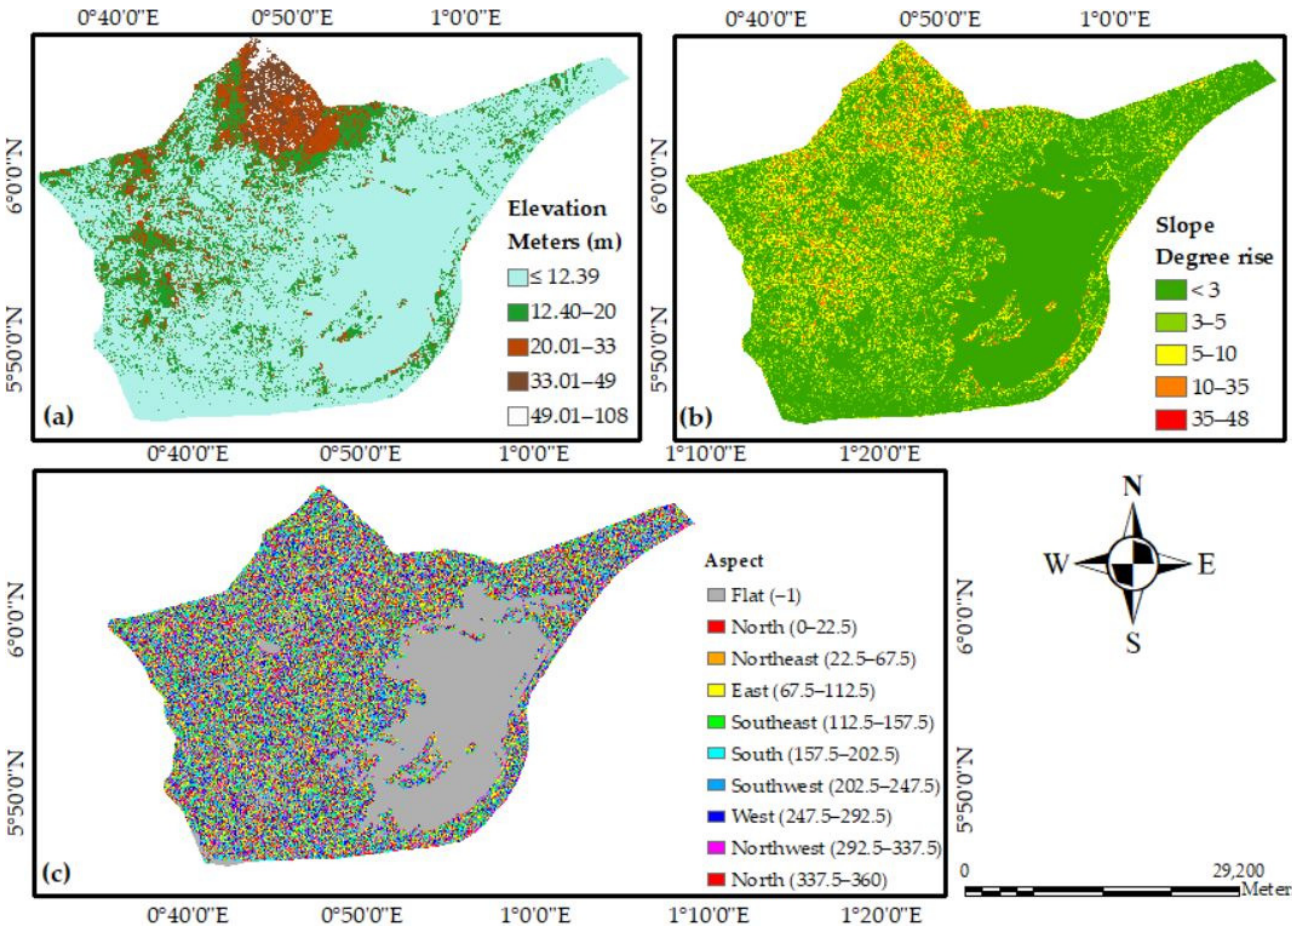
Figure 7. ( a ) Elevation, ( b ) slope, and ( c ) aspect